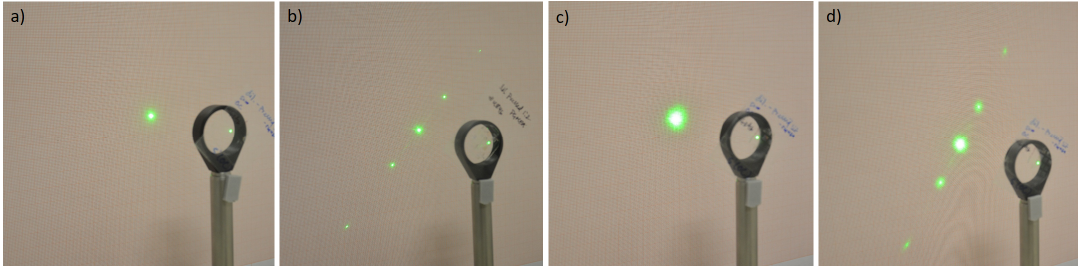
Figure 8. Photographs illustrating the optical effect of the differently stuctured areas by passing a green laser beam through the sample in 4 different areas: ( a ) unstructured, ( b ) only grating, ( c ) only diffusor and ( d ) grating on top of diffusor. The difference between b and d can be clearly seen.